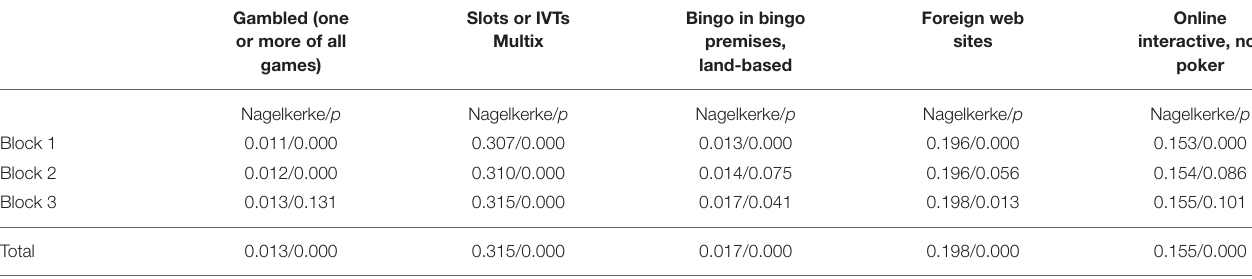
TABLE 3 | Accumulated explained variation (Nagelkerke R Square) and significance per block.